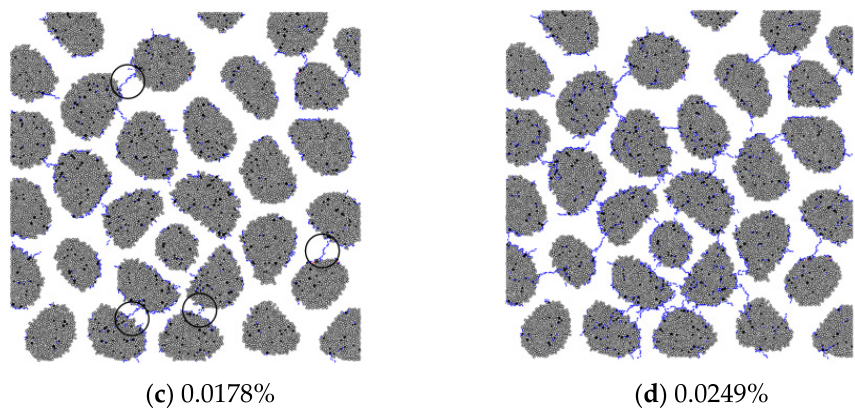
Figure 5. AAR-induced microcracks in GC20-1-5%.